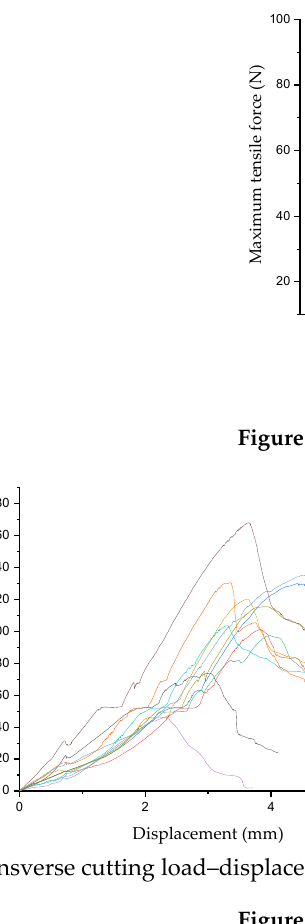
Figure 9. Results of transverse cutting test: A is approximately regarded as the dividing point be- tween elastic stage and yield stage; B is approximately regarded as the dividing point between yield stage and strengthening stage; C is approximately regarded as the point of tensile strength.